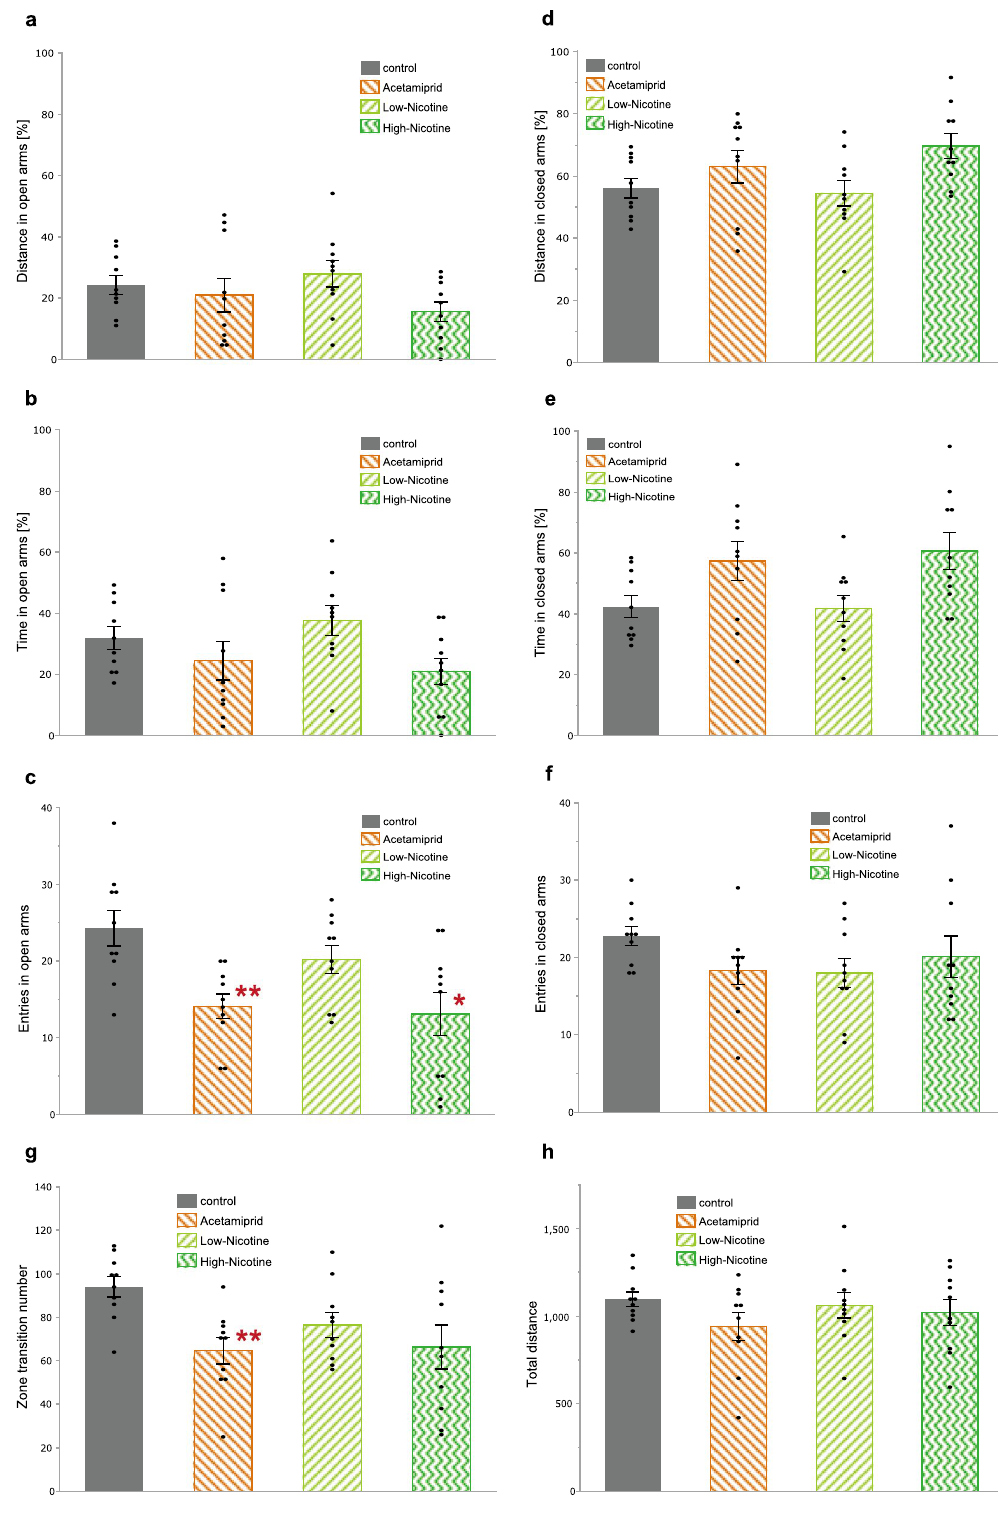
Figure 2. Behavioral effects of acute exposure of 20 mg/kg acetamiprid and 0.33 or 1.65 mg/kg nicotine in the elevated plus-maze (EPM) test ( a ) Distance traveled in open arms; ( b ) Time spent in open arms; ( c ) Entries into open arms; ( d ) Rate of open arms selection; ( e ) Distance traveled in closed arms; ( f ) Time spent in closed arms; ( g ) Entries into closed arms; ( h ) Rate of closed arms selection; ( i ) The number of movements between zones; and ( j ) Total distance traveled in EPM. Data are represented as mean ± SEM, * p < 0.05, ** p <